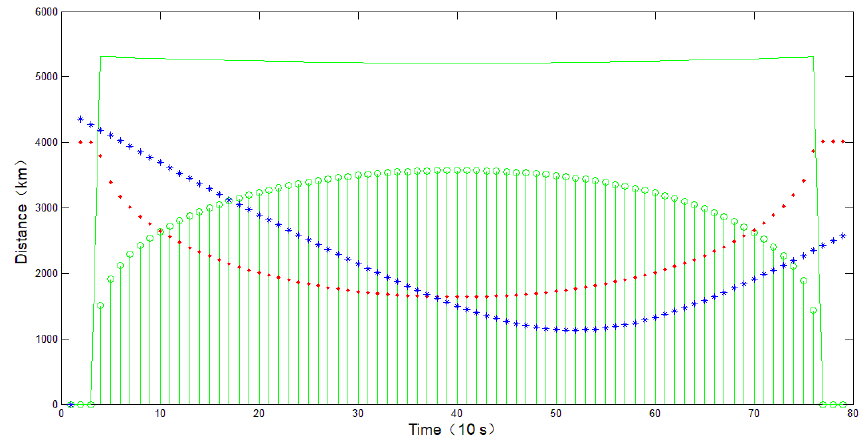
Figure 13. Time sequence of detection area variation.